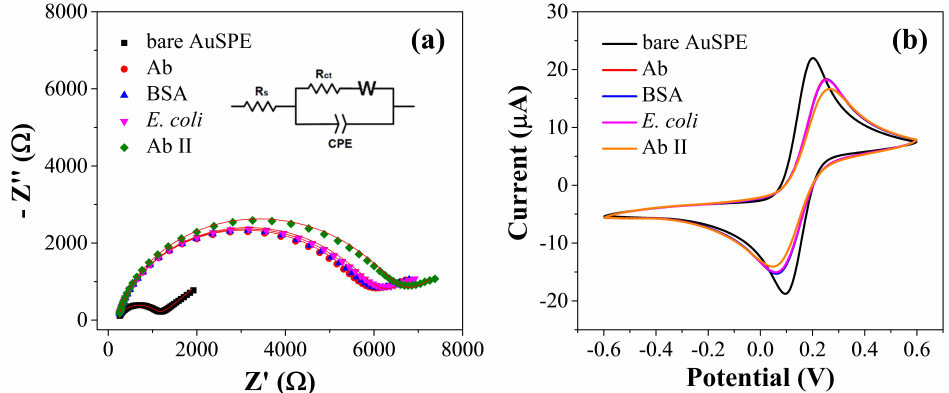
Figure 6. ( a ) EIS and ( b ) CV of the step-by-step immunosensor development and E. coli detection in 10 mM Fe(CN) 63 − / Fe(CN) 64 − solution at pH